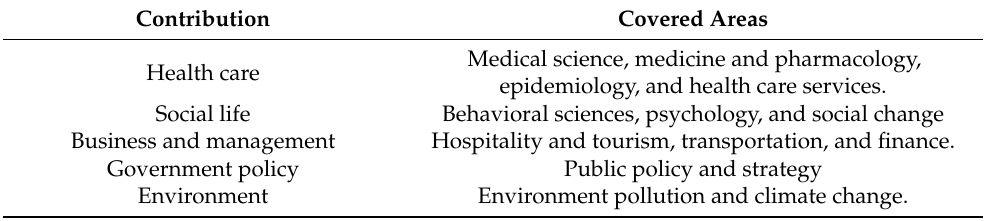
Table 1. Contribution